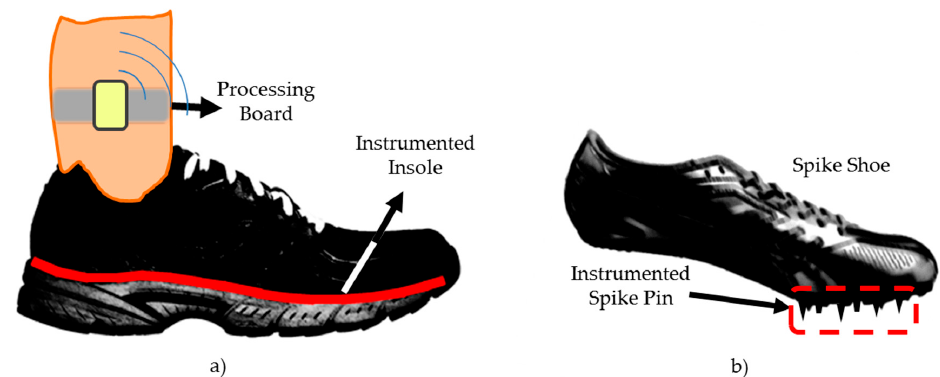
Figure 7. Plantar pressure smart sensors: ( a ) in-shoe insole and ( b ) spike shoes for sprinters.